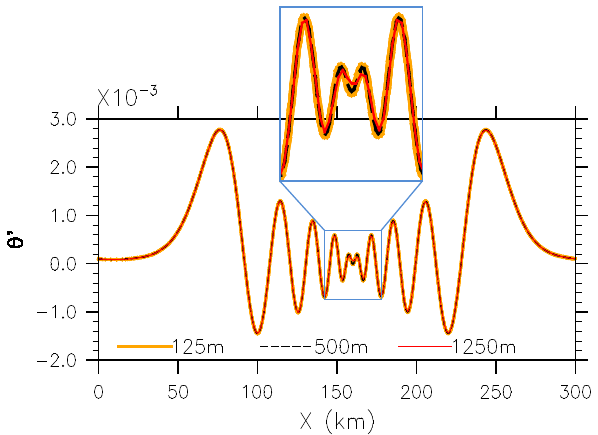
FIG. 10. Profiles of potential temperature perturbation along the 5000-m height for 2 Figure 10. Profiles of potential temperature perturbation along the 5000m height for (cid:49) ¯ x = 125m (thick solid line), (cid:49) ¯ x = 500m (thin 125x ∆ = m (thick solid line), 500x ∆ = m (thin dashed line), and 1250x ∆ = m (thin 3 dashed line), and (cid:49) ¯ x = 1250m (thin solid line) using eighth-order solid line) using 8th-order basis polynomials per element for the inertia–gravity wave. All 4 basis polynomials per element for the inertia–gravity wave. All models use 250z ∆ = m. 5 models use (cid:49) ¯ z =